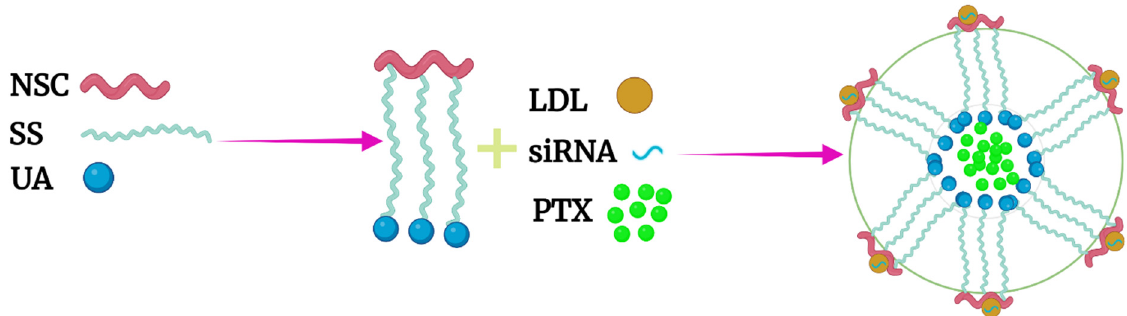
Figure 8. Dual pH- and redox-responsive micelles were formed from the binary polymer of LDL and N-succinyl chitosan-cystamine-uronic acid (LDL-NSC-SS-UA). The LDL ligand on the exterior of the micelle binds tightly to the cholesterol-modified siRNA. In contrast, PTX was located in the interior and was released by redox and pH stimuli.